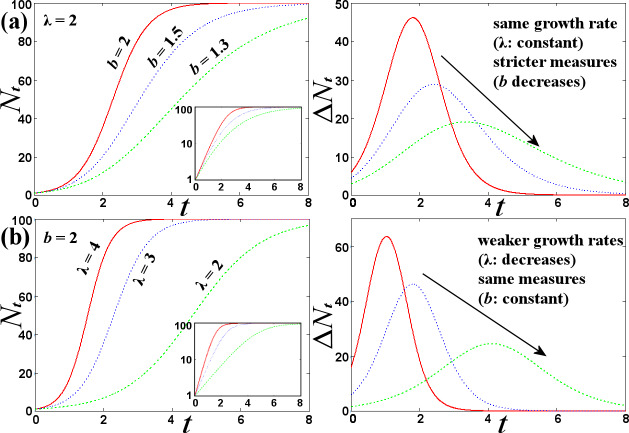
Plots of total Nt and new ΔNt infected cases according to model (1), showing the flattening of the spread curve with the interplay of (a) stricter measures (decreasing b), or (b) weaker rates (decreasing λ). (Input panels show graphs on semi-log scale.).